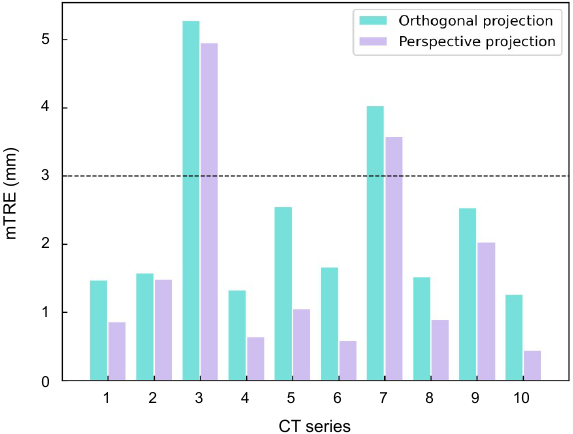
Figure 6. The mTRE of different projection loss